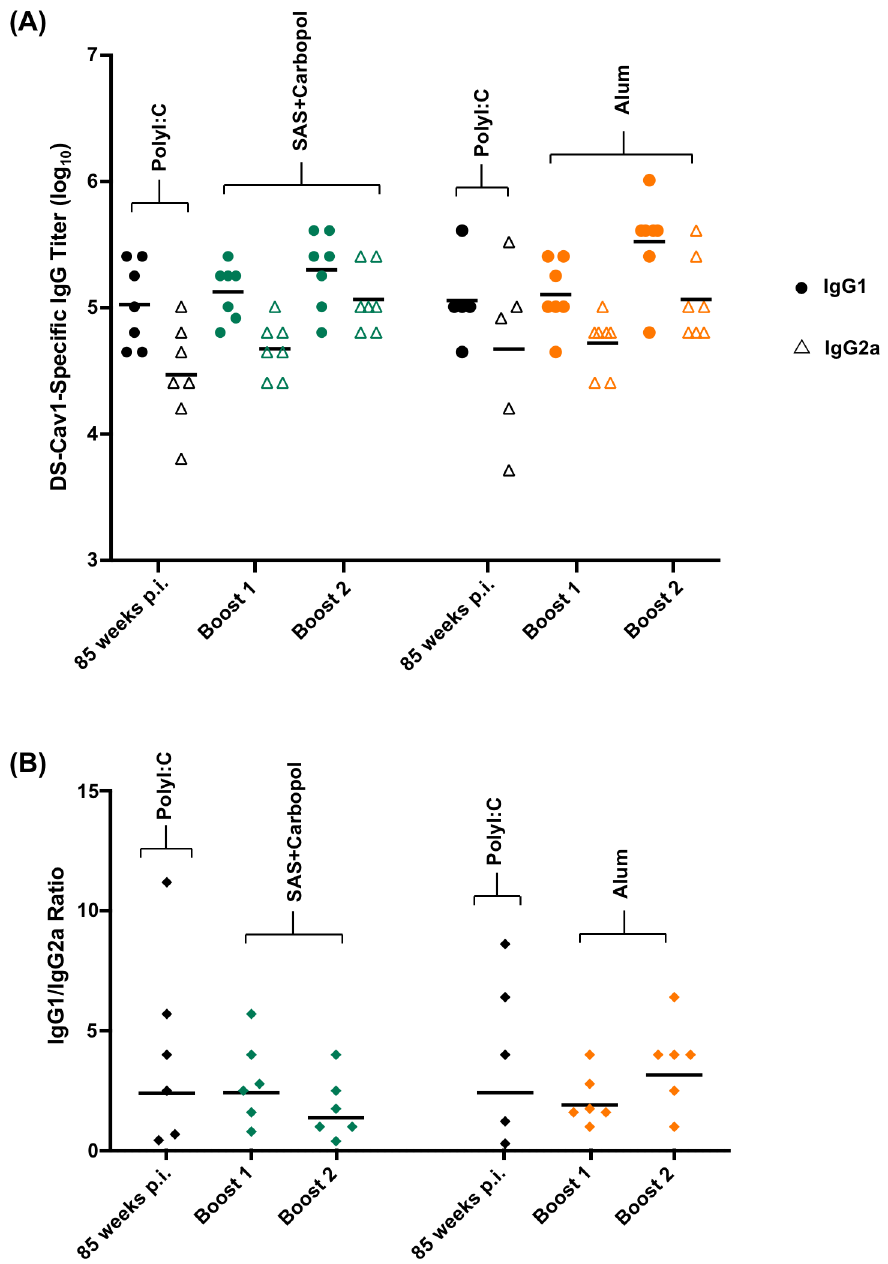
Fig 6. Prime-boost vaccination with different adjuvant formulations induced a balanced Th1/Th2 IgG response in elderly mice. (A ) Pre-immunized elderly mice (~85 weeks wait) were administeredDS-Cav1 formulated with SAS + Carbopol or Alum. Sera were assayed by ELISA for their DS-Cav1 specific IgG1 and IgG2a antibody responses. Closedcircles and open trianglesrepresent IgG1 and IgG2a antibodytiters, respectively. (B ) The ratios of IgG1 to IgG2a for each animalin the groups were calculatedfrom the upper panel. p values were determinedby two-tailed Wilcoxon matched-pairssigned rank test, p = > 0.05 (ns). Associatedraw data is listed in S6